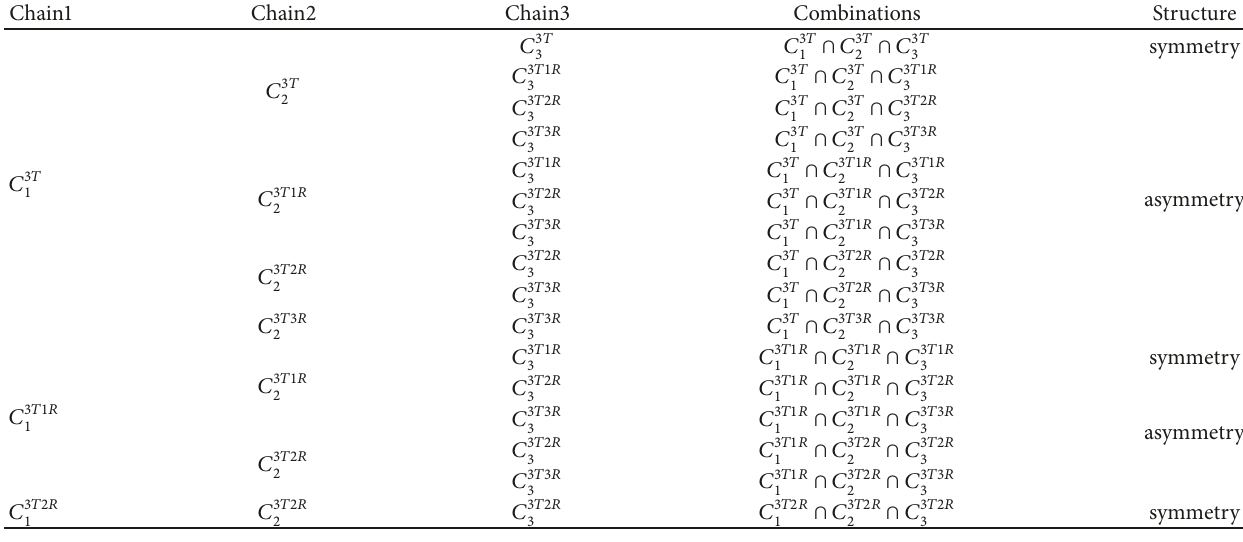
Table 1: The combinations of the branched robots with 3 T